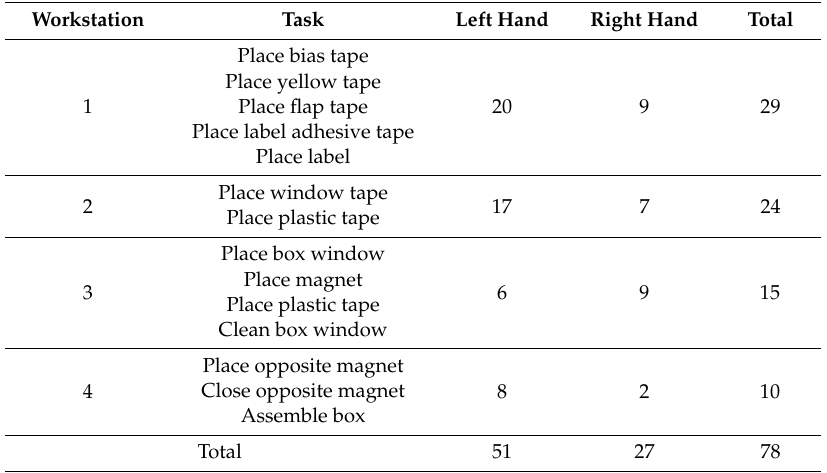
Table 8. Ine ffi cient therbligs in the redesigned process.